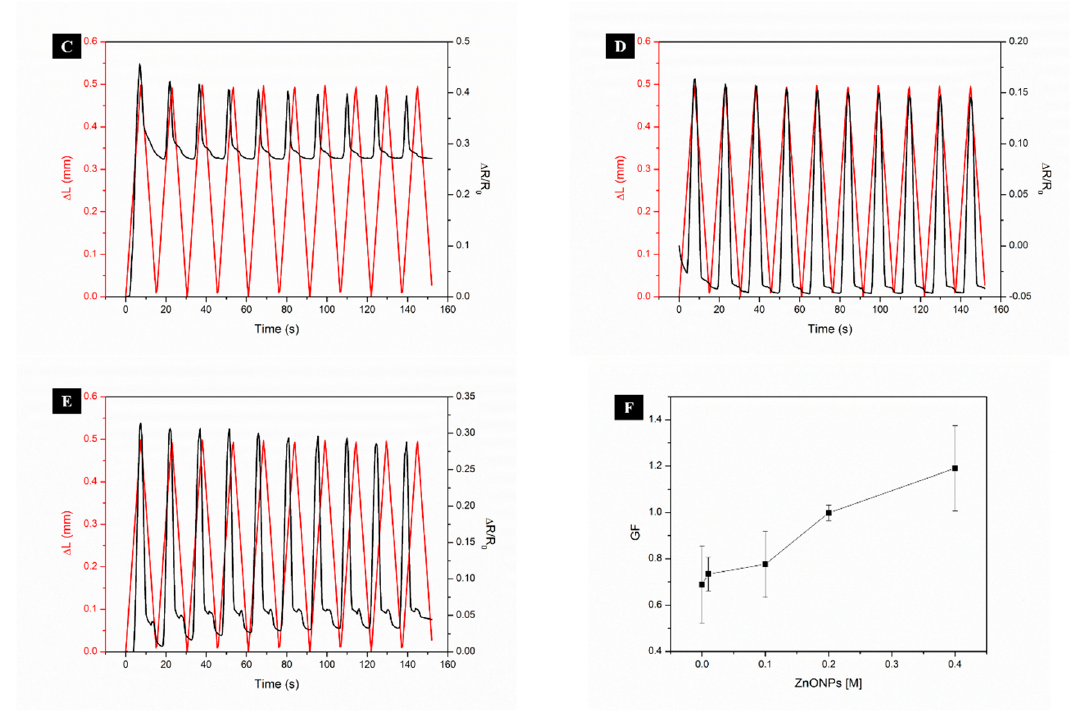
Figure 7. Electromechanical response of flax treated with AgNPs ( A ), flax treated with AgNPs and different ZnONPs precursor concentration from 0.05 to 0.4 M ( B – E ), respectively, and gauge factor (GF) values ( F ).